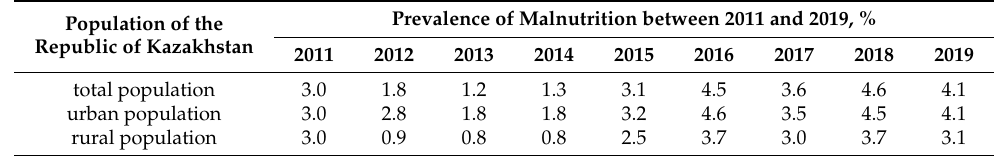
Table 2. The prevalence of undernourishment (PoU) in the Republic of Kazakhstan (source: Bureau of National Statistics of the Agency for Strategic Planning and Reforms of the Republic of